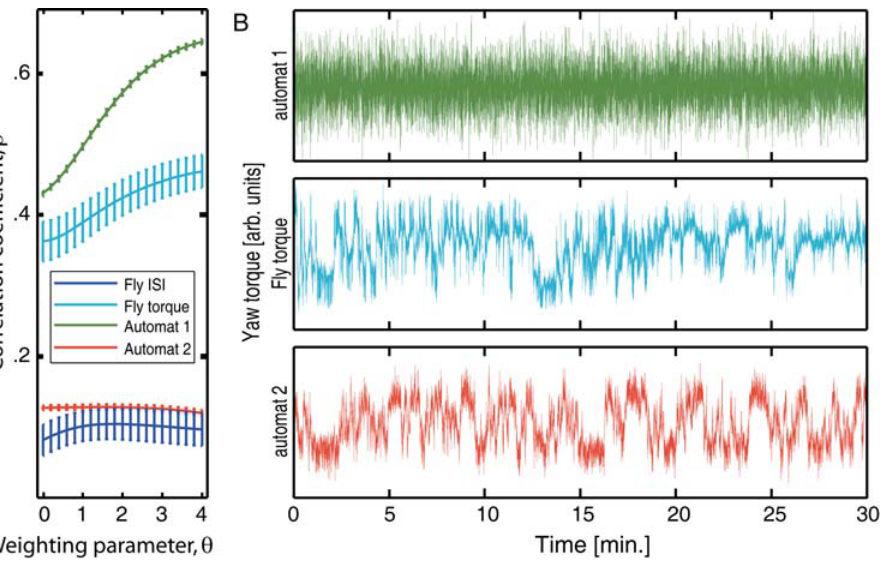
Figure 6. Nonlinearity implies instability. A–S-Map results. Depicted are the averaged results for fly ISIs and raw yaw torque series (for clarity, only openloop data are shown here), together with two automat simulations. The fly ISI series shows a slightly improved forecast skill with increasingly nonlinear S-map solutions (increasing H ). Fly yaw torque series yield both a better overall forecast skill as well as increased nonlinear improvement. The automat simulation can be tuned to produce both linear and nonlinear output. B–Sample raw yaw torque data traces from a real fly and the two versions of the simulated agent depicted in A (automat 1, automat 2). S-Map results for the other two groups are depicted in Fig. S5.